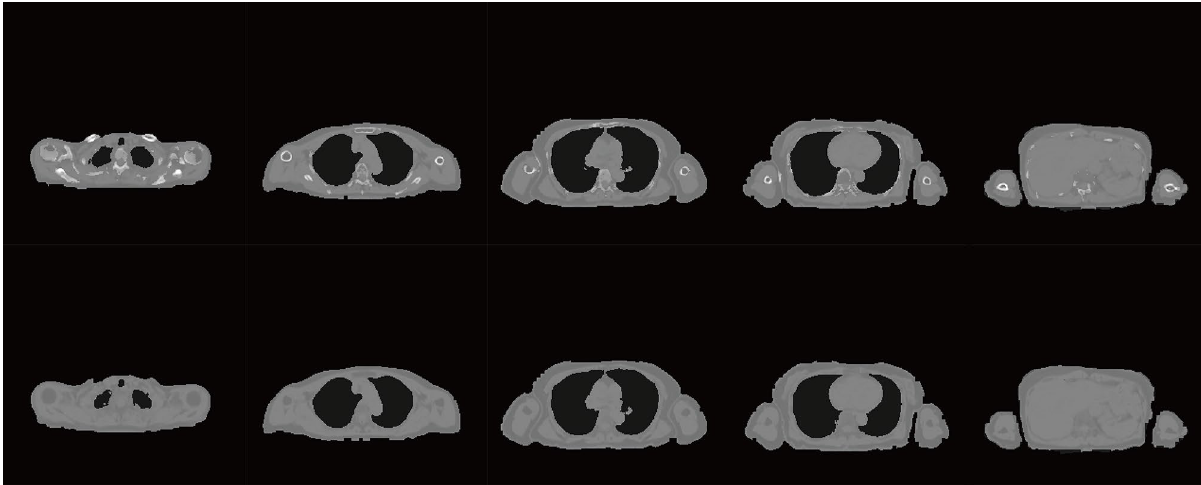
Figure 6. Synthesised CTs using U-GAT-IT + MIND and the conventional